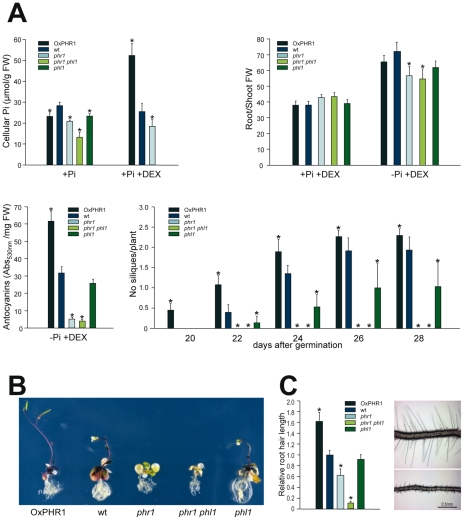
Effect of phr1 and phl1 mutations and PHR1 overexpression on physiological responses to Pi starvation.(A) Histograms of metabolic (Pi and anthocyanin content) and developmental (root/shoot fresh weight ratio and number of siliques per plant) parameters of wild type (wt), phr1, phl1, and phr1 phl1 mutants, and GR:PHR1 overexpression line (OxPHR1). For analysis of Pi content, plants were grown for 12 days in complete medium (+Pi) and +Pi supplemented with 5 µM dexamethasone (+Pi+DEX). Anthocyanin content was measured in plants grown for 12 days in Pi-lacking medium supplemented with 5 µM DEX (−Pi+DEX). Root/shoot fresh weight (FW) ratio was measured in plants grown for 10 days in +Pi medium, and then transferred for 6 days to +Pi+DEX or −Pi+DEX media. Number of siliques was scored in plants grown for 9 days in +Pi and transferred to −Pi+DEX. Day 0 corresponds to start of germination. (B) Phenotypes of wild type, phr1, phl1, and phr1 phl1 plants, and a OxPHR1 line grown for 9 days in complete medium, then transferred to −Pi+DEX for 13 days. The image reflects a phenotype frequent at the time examined. (C) Root hair size of wild type, phr1, phl1, and phr1 phl1 plants, and a OxPHR1 line (left) and a detail (right) showing root hairs of wild type (top) and phr1 phl1 plants (bottom). Plants were grown in vertical plates for 12 days in Pi-lacking medium. Scale bar, 0.5 mm. Asterisks indicate significant differences with wild type (p<0.05, Student's t-test).